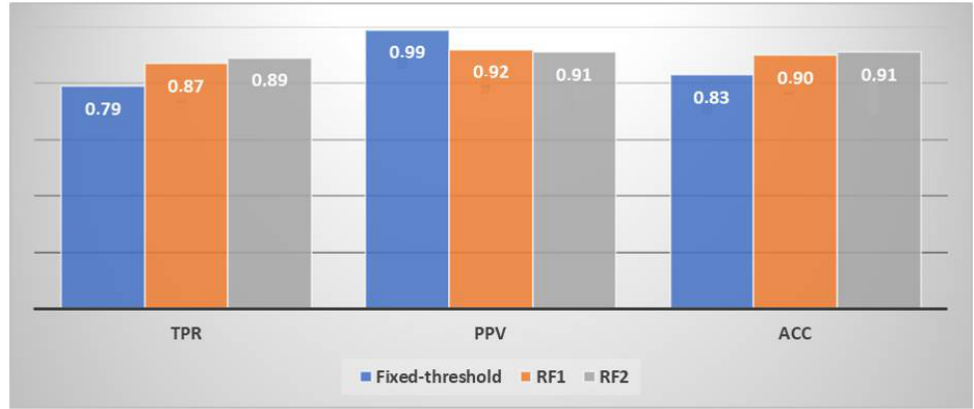
Figure 7. Comparison of average recall, precision, and ACC for each volcano for the fixed threshold model, RF1 and RF2.